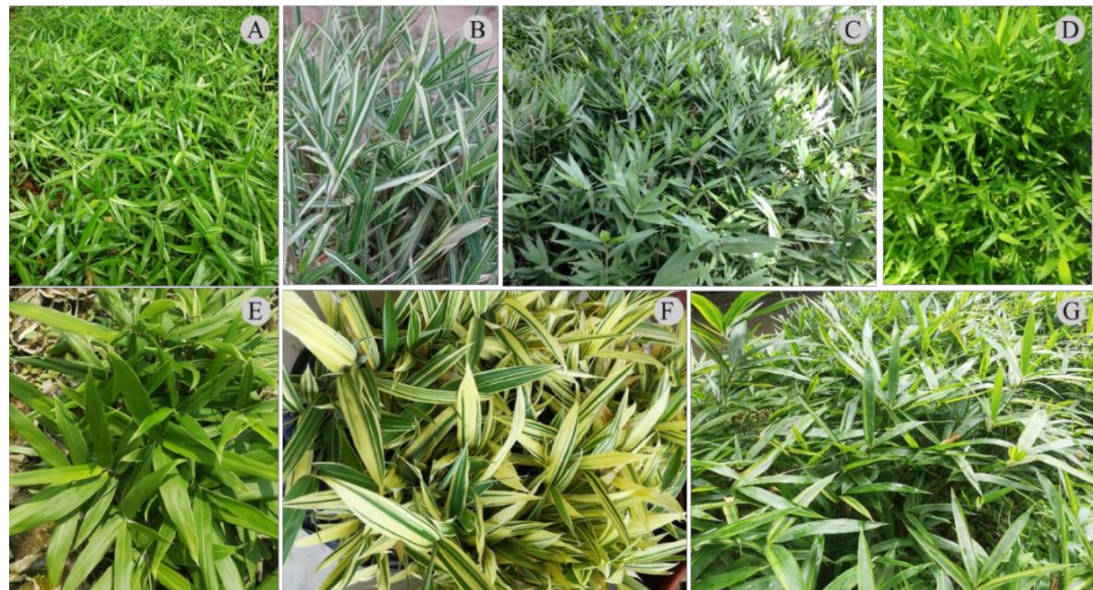
Figure 1. Morphological comparison of seven dwarf ornamental bamboos grown in the bamboo garden and Baima experimental base of Nanjing Forestry University, Nanjing, China. ( A ) Pleioblastus argenteostriatus . ( B ) Pleioblastus fortunei . ( C ) Pleioblastus pygmaeus . ( D ) Pleioblastus pygmaeus ‘Disticha’. ( E ) Sasaella glabra . ( F ) Sasaella glabra ‘Albostriata’. ( G ) Sasaella kongosanensis